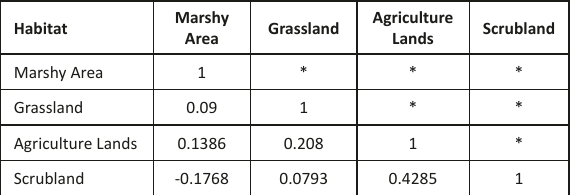
Table 4. Sorensen’s similarity index values for birds species richness in different habitats of Manjeera Wildlife Sanctuary, Andhra Pradesh, India